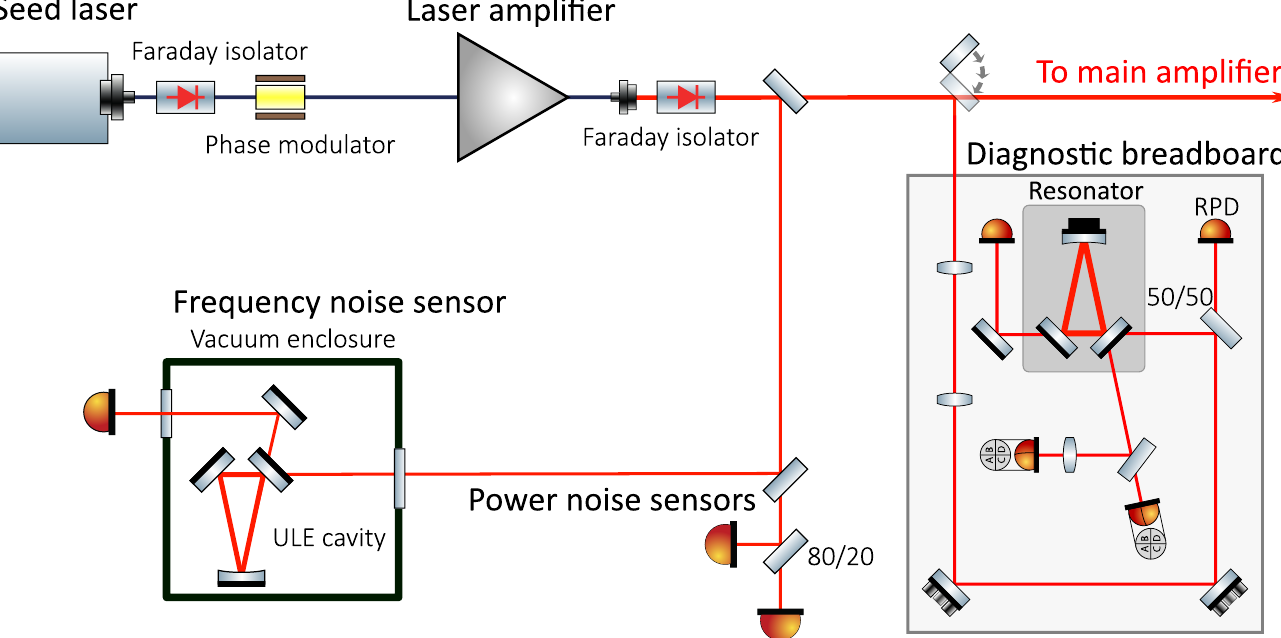
Figure 1. The simplified stabilization setup shows the seed laser with 1550nm wavelength, which was coupled via a fiber Faraday isolator to the fiber phase modulator and was amplified by the booster optical amplifier. A Faraday isolator was placed in the 115mW free space beam. This was to prevent reflections back to the amplifier. Parts of the beam were sent to power sensors and the frequency reference cavity. The main fraction of the beam was analyzed with the diagnostic